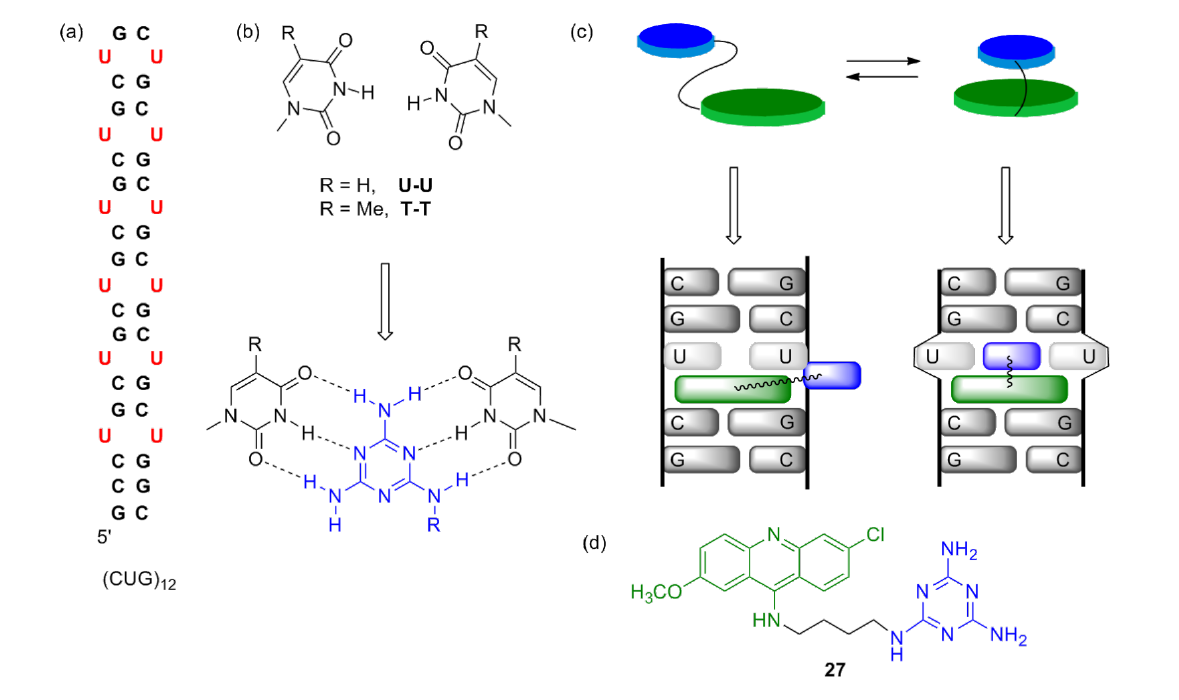
Figure 8: (a) Hairpin structure of CUG exp seen in (CUG) 12 . (b) U–U or T–T mismatches with no inter-strand hydrogen bonds, hypothetically forming base-triplet with 2,4,6-triamino-1,3,5-triazine. (c) Aromatic recognition unit tethered to intercalator in stacked and unstacked conformation. (d) Ligand 27 , an inhibitor of MBNL1N